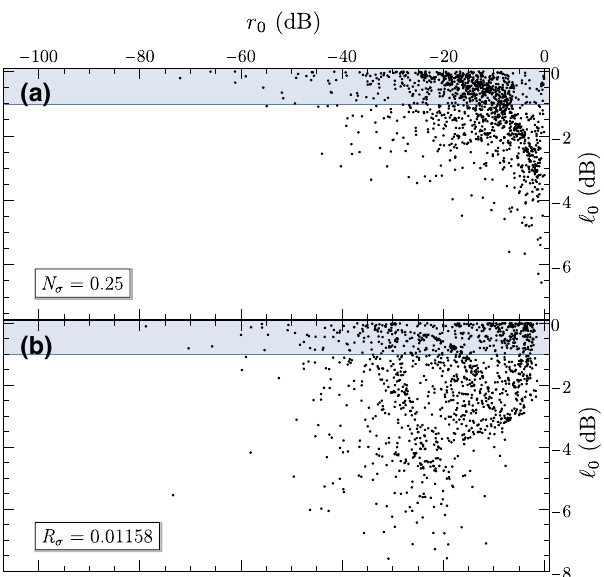
FIG. 10. Pairwise plot of the minimum of the extinction ratio r 0 and the maximum of the insertion loss l 0 in the presence of (a) charge noise for 1200 samples from a noise distribution with a mean of N μ = 0 and standard deviation N σ = 0.25 and (b) flux noise for 1200 samples from a noise distribution with a mean of R μ = 0 and standard deviation R σ = 0.01158. Shading indi- cates the device yield ϒ —the fraction of points that constitute . The parameters and offset charge for ideal tuning are the same r ϒ 0 as in Fig. 4. The results shown are specifically for transmission between port 1 and port 2, but are representative of the circuit overall due to circuit symmetry and the sampling from identical noise distributions at each island.